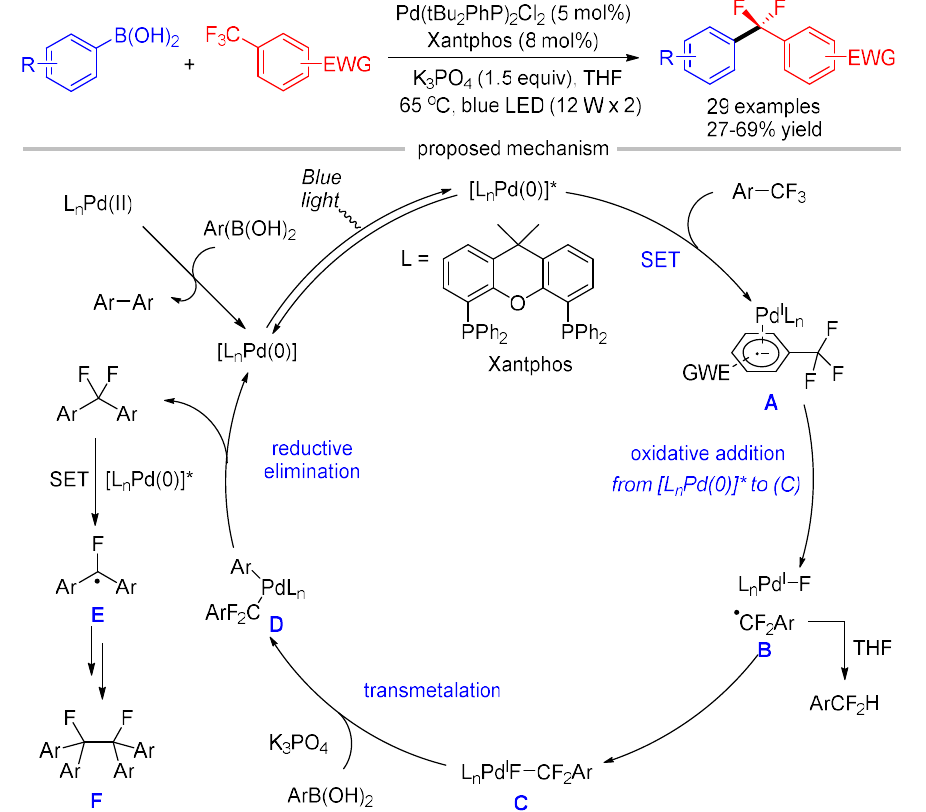
Scheme 18. Visible-light-induced palladium-catalyzed defluoroarylation of